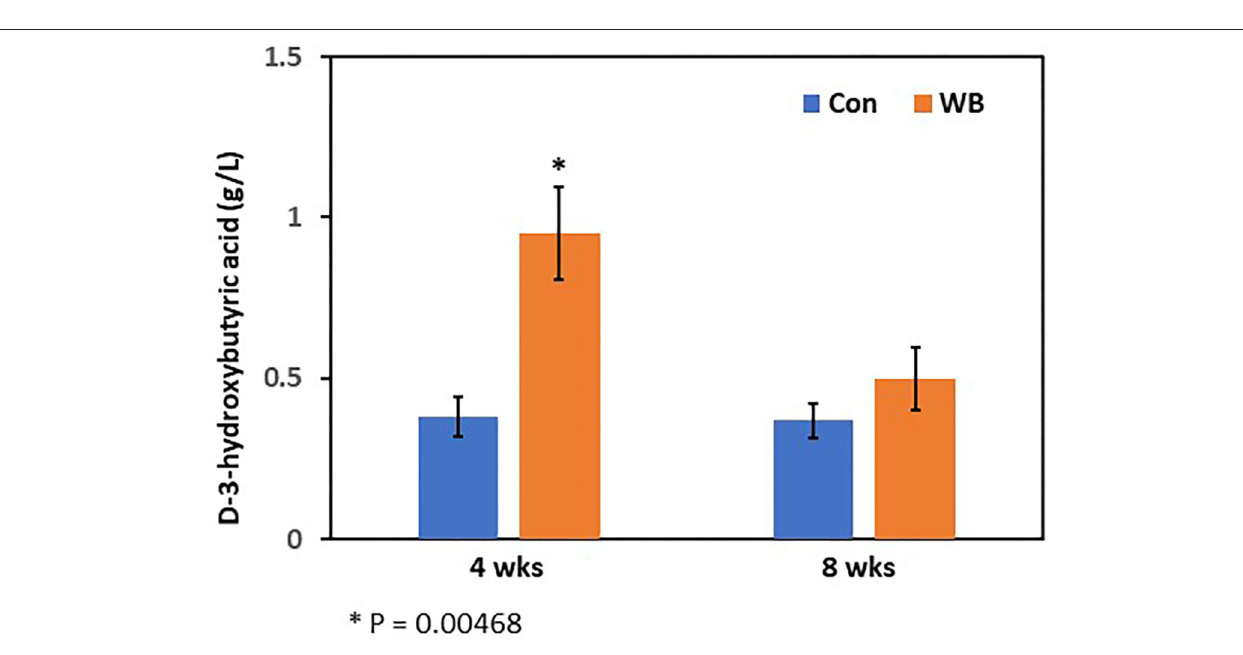
controls at 4 wks of age. Furthermore, raffinose contents were significantly lower in plasma samples at 8 wks of age.